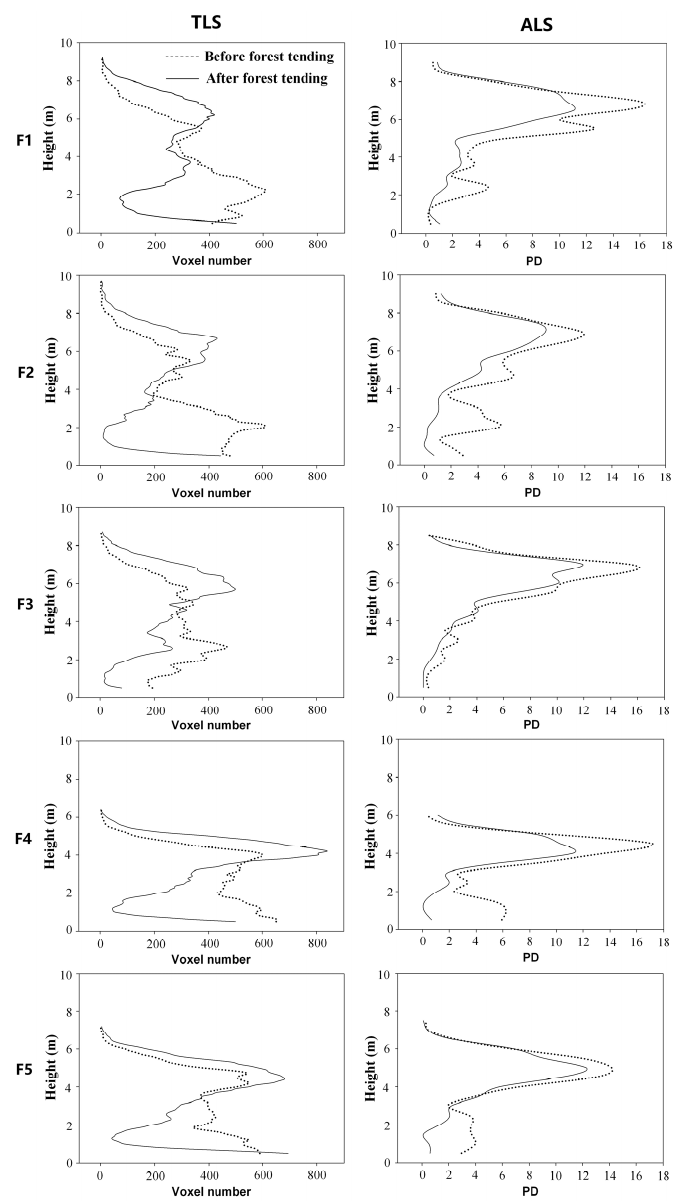
Figure 3. Canopy height profiles (CHPs) in plots from Terrestrial Laser Scanning (TLS) and Airborne Laser Scanning (ALS) data before and after forest tending. The CHPs from TLS were drawn from the number of filled voxels at every layer (0.1 m interval), and the CHPs from ALS were drawn using the percentile distribution of return points at every layer (0.5 m interval).